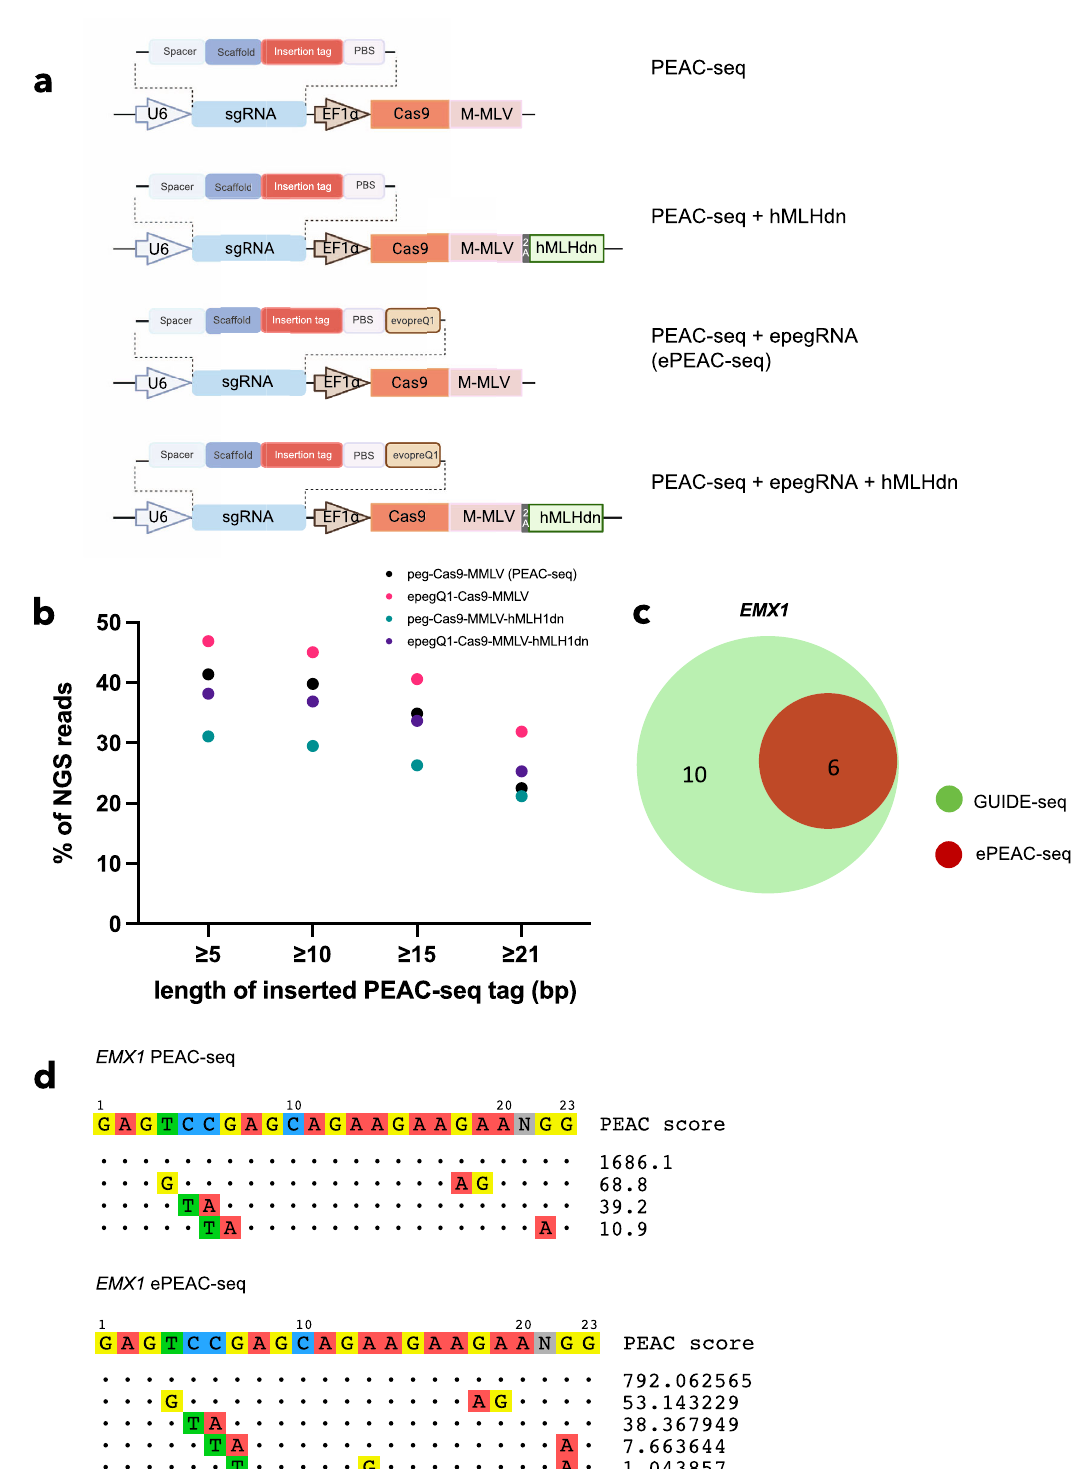
Fig.5|ePEAC-seqisanenhancedversionofPEAC-seqwithhighersensitivityto identify off-targets. a Schematic representation of the three modi fi ed versions of PEAC-seq. b The insertion frequencies of PEAC-seq tag in PEAC-seq and its three